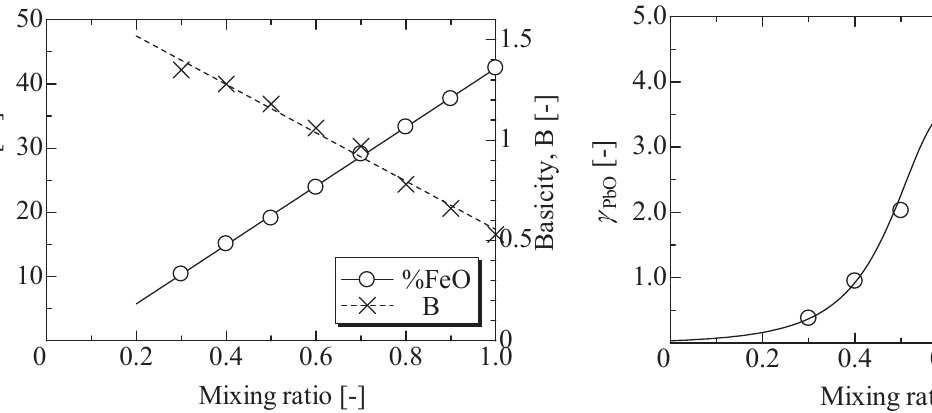
Figure 8. Dependence of the activity coefficient of PbO on the mixing